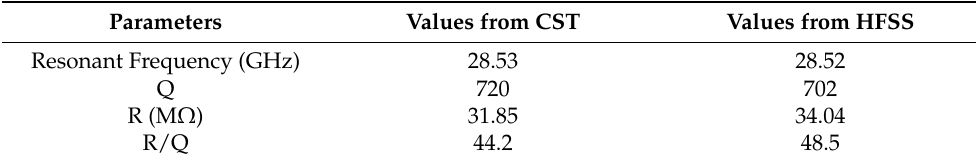
Table 5. Comparison of the simulated cavity parameters (input/ output cavities).